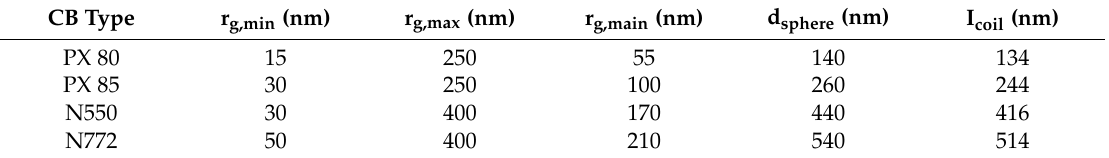
Table 3. Particle size distribution of CB dispersed in 96% ethanol. Particle sizes calculated as radius of gyration (r g ) as well as geometrical sphere diameter and end-to-end distance of random coils.